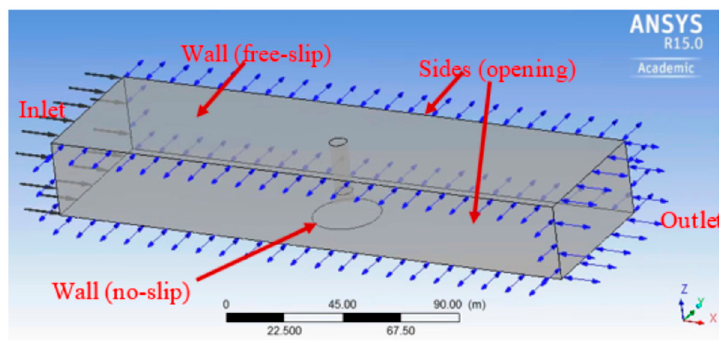
Figure 7. Simulation model with boundary conditions.